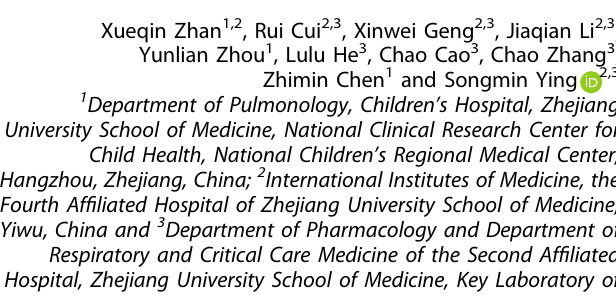
Fig. 1 Rad50 de fi ciency alleviated LPS-induced in fl ammation in macrophages both in vitro and in vivo. a – h Primary macrophages from Rad50 fl ox/ fl ox or LysM cre Rad50 fl ox/ fl ox mice were administrated with LPS for 6 h. a Representative structured illumination microscopy images of macrophages of extranuclear dsDNA and the statistical analysis of the number of extranuclear dsDNA foci in each macrophage. b Representative structured illumination microscopy images of macrophages stained with EdU (newly synthesized DNA) and mitotracker (mitochondria) were shown and the number of EdU foci in each macrophage was counted. (50 cells at least per group; N-SIM, original magni fi cation, ×400). c The expression of RAD50 was determined by western blot. d Representative structured illumination microscopy images of primary macrophages, which were stimulated with LPS and stained with dsDNA and RAD50 antibodies, and the co-localized foci for dsDNA and RAD50 in various z-layers (z1 – z4) in remaining images. e , f Western blot was performed to examine the activation of STING and the expression of p-p65. g , h Relative levels of Cxcl1 and Cxcl2 of peritoneal-derived macrophages (PDMs) and alveolar macrophages (AMs) were determined using quantitative PCR. i – k Rad50 fl ox/ fl ox and LysM cre Rad50 fl ox/ fl ox mice ( n = 3 – 6) were instilled intratracheally with LPS (1.25 mg kg − 1 ) or the equivalent volume of PBS as control for 12 h. In the bronchoalveolar lavage fl uid (BALF), i the total number of in fl ammatory cells was quanti fi ed, j the number of neutrophils was calculated, k BCA assay was used for measuring protein concentration in BALF. l